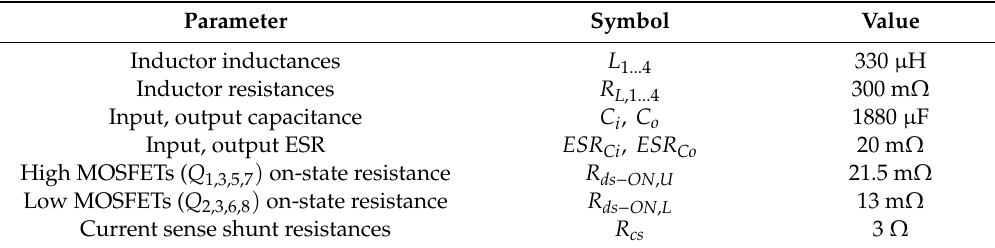
Table 1. Prototype converter parameters.